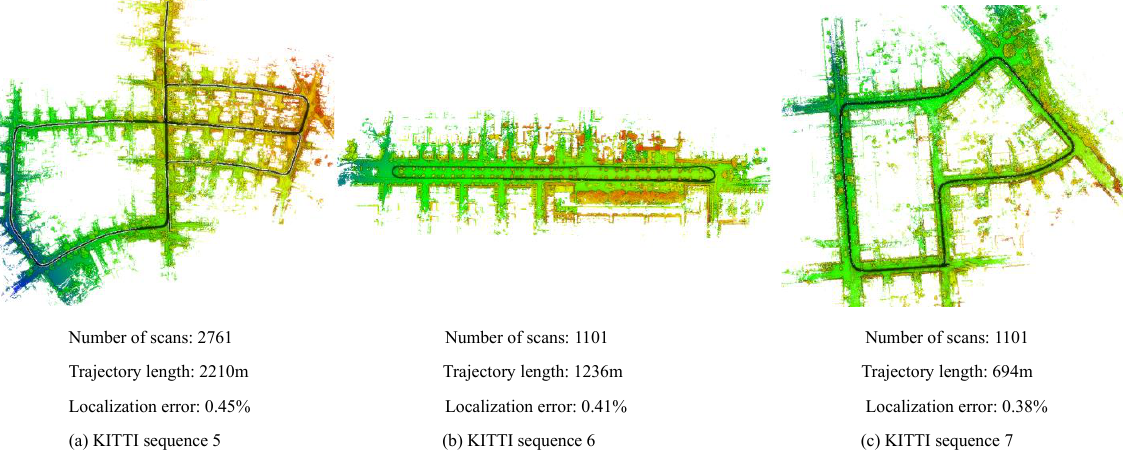
Figure 11. Our laser odometry results on the KITTI dataset. The color of point clouds is rendered by height. The black line inside each subfigure is the estimated trajectory of the